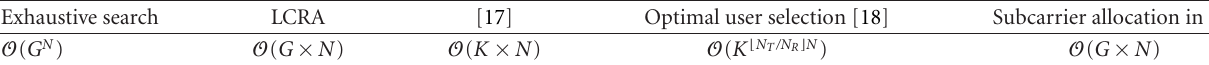
Table 1: Algorithm